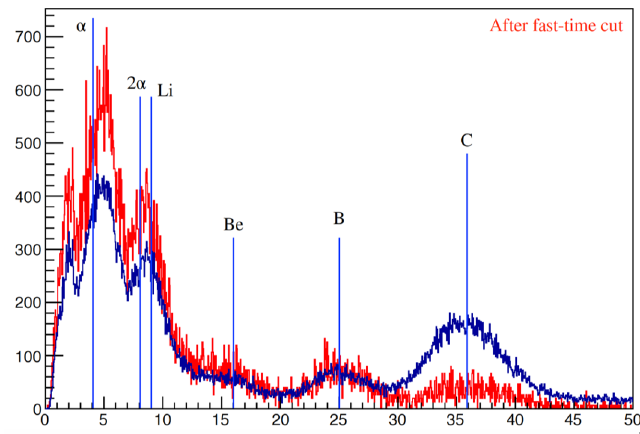
Figure 7. The squared charge of the residual nucleus. Vertical lines mark squared charge for particular nuclei. The blue spectrum shows all events, whereas the red line corresponds to the rough time cut for the leading and the scattered